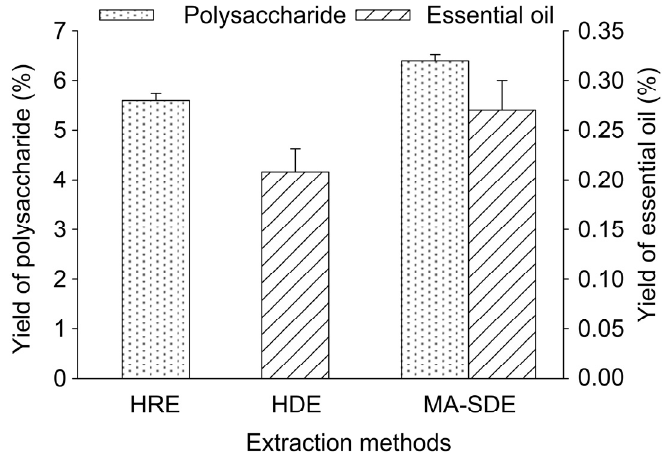
Figure 5. Effect of different extraction methods on yields of essential oil and polysaccharide. Error bars indicate standard deviation ( n = 3).